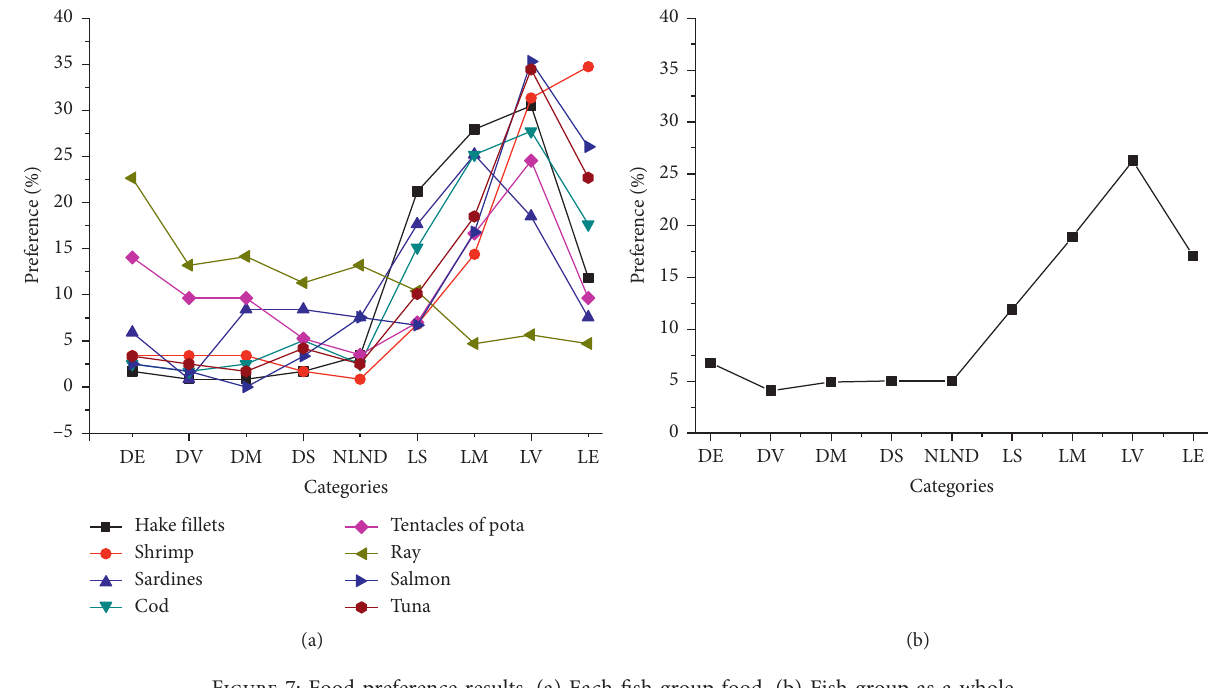
Figure 7: Food preference results. (a) Each fish group food. (b) Fish group as a whole.